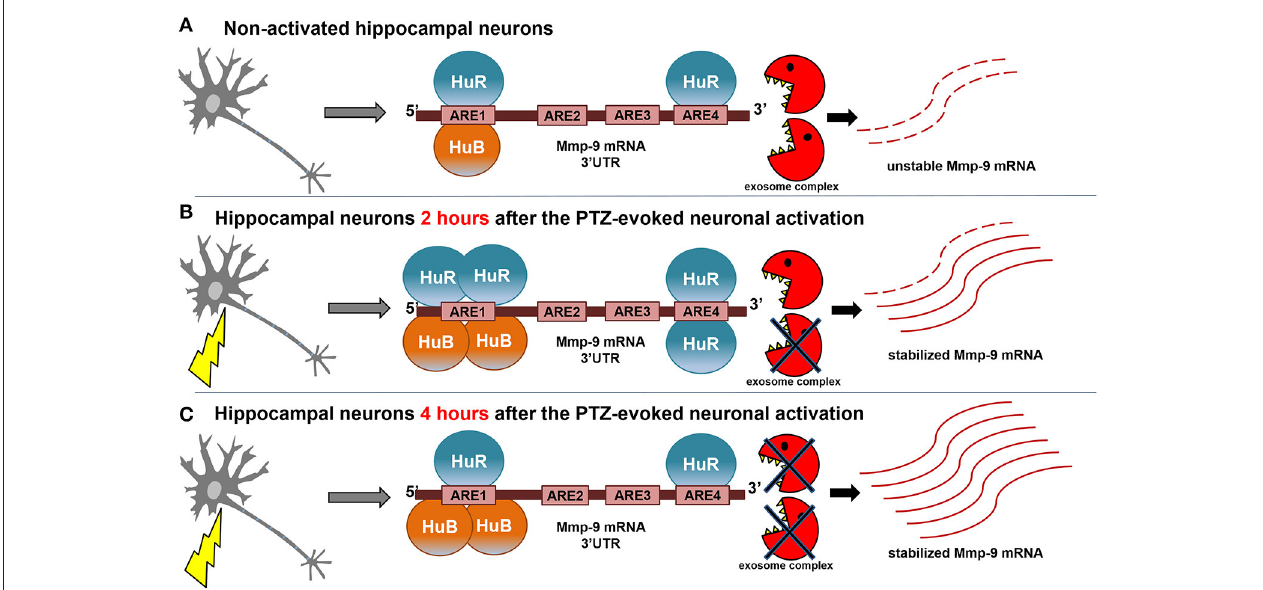
FIGURE 8 | Model of neuronal activity-triggered stabilization of Mmp-9 mRNA . (A) In the non-depolarized hippocampal neurons, a few molecules of HuB and HuR are bound to the Mmp-9 mRNA 3 ′ UTR (HuB is attached to ARE1 and HuR is associated with ARE1 and ARE4). As a result, Mmp-9 mRNA decay greatly enhances Mmp-9 mRNA stabilization, and Mmp-9 mRNA is expressed at low levels. (B) After seizure induction (2h), there is increased binding of HuB to ARE1 as well as HuR to ARE1 and ARE4 motifs of the Mmp-9 mRNA 3 ′ UTR. This leads to significant augmentation in Mmp-9 mRNA stability and, consequently, in its cellular abundance. (C) The interactions of HuR with ARE1 and ARE4 are reduced at 4h after seizure induction, whereas HuB binding to ARE1 remains stably enhanced, which maintains elevated Mmp-9 stabilization and generates further accumulation of Mmp-9 transcripts.